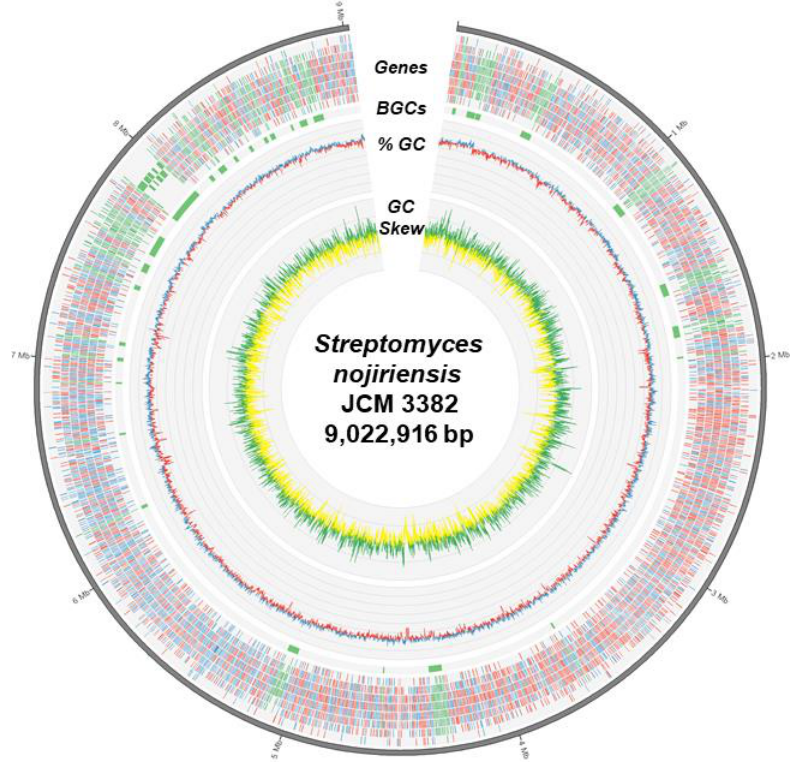
Figure 1. A circular diagram representing the genome of S. nojiriensis JCM 3382. From the outermost track to the center: (i) predicted genes (blue/red for forward/reverse strand and green for BGCs), (ii) 30 predicted BGC regions in blocks, (iii) GC content (blue/red for above/below average), and (iv) GC skew (green: >0 and yellow: <0). Table 2. Predicted biosynthetic gene clusters of S. nojiriensis JCM 3382.